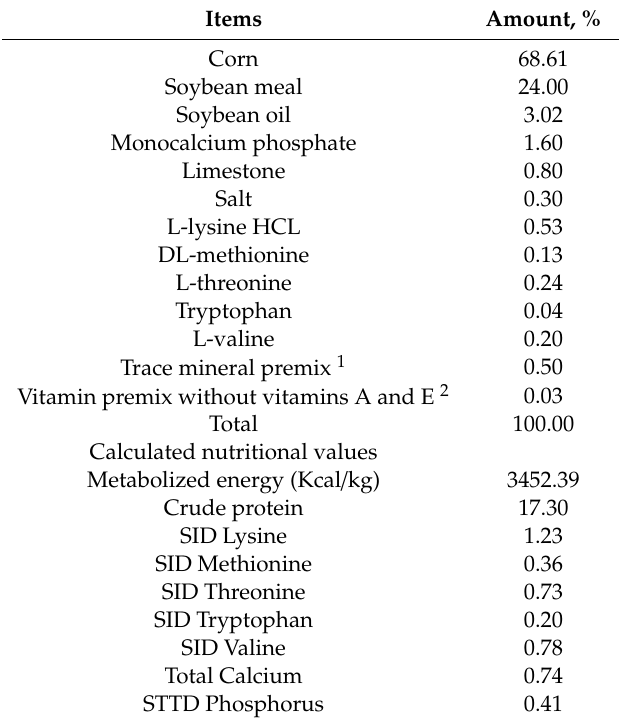
Table 1. Composition of the diet in the experimental 1 (as-fed